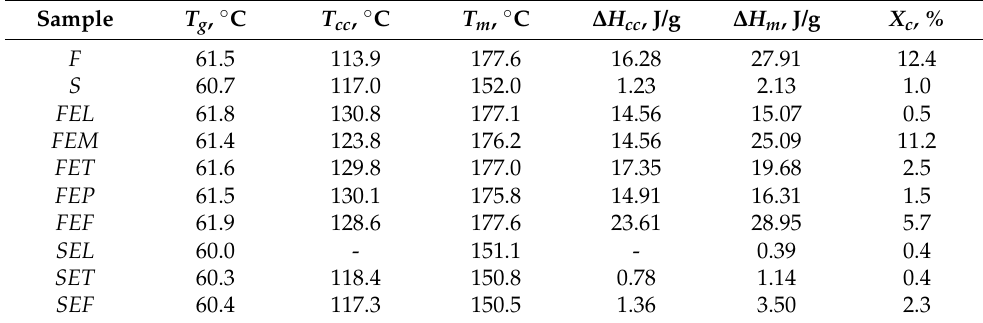
Table 3. Thermal characteristic of the samples.